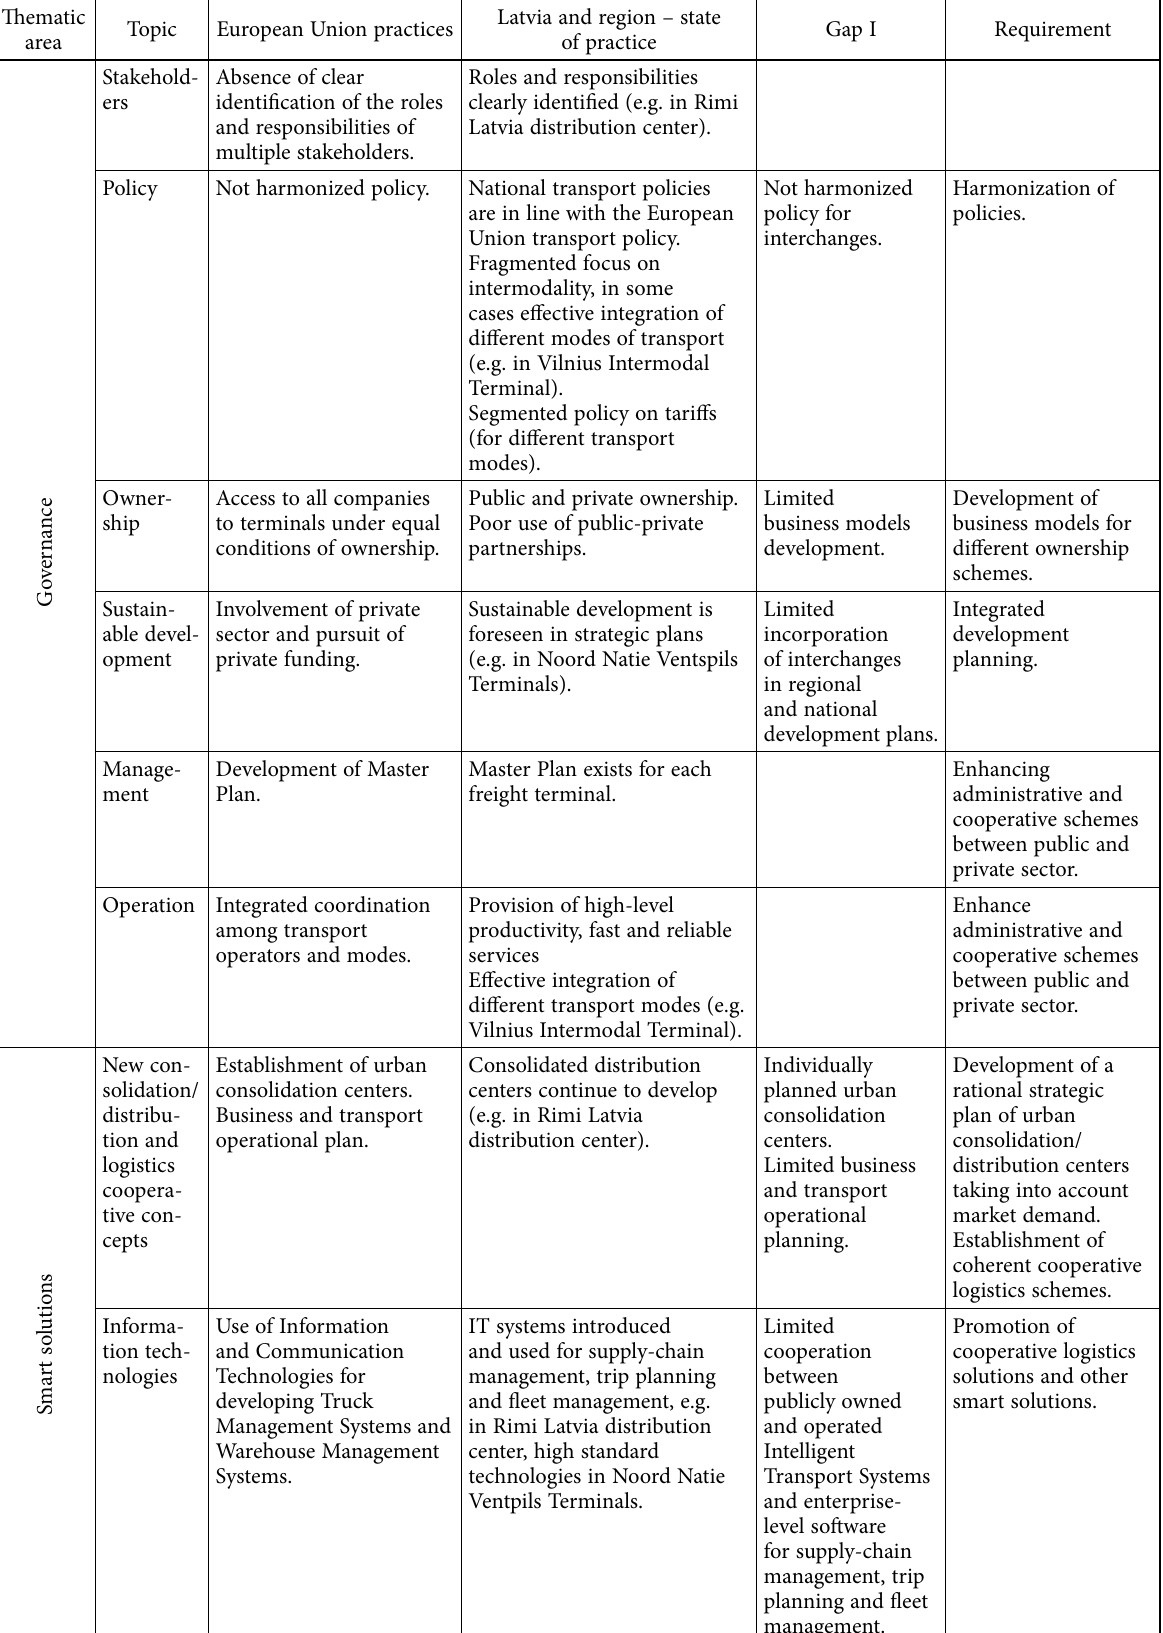
Table 6. Identification of gaps/requirements for freight